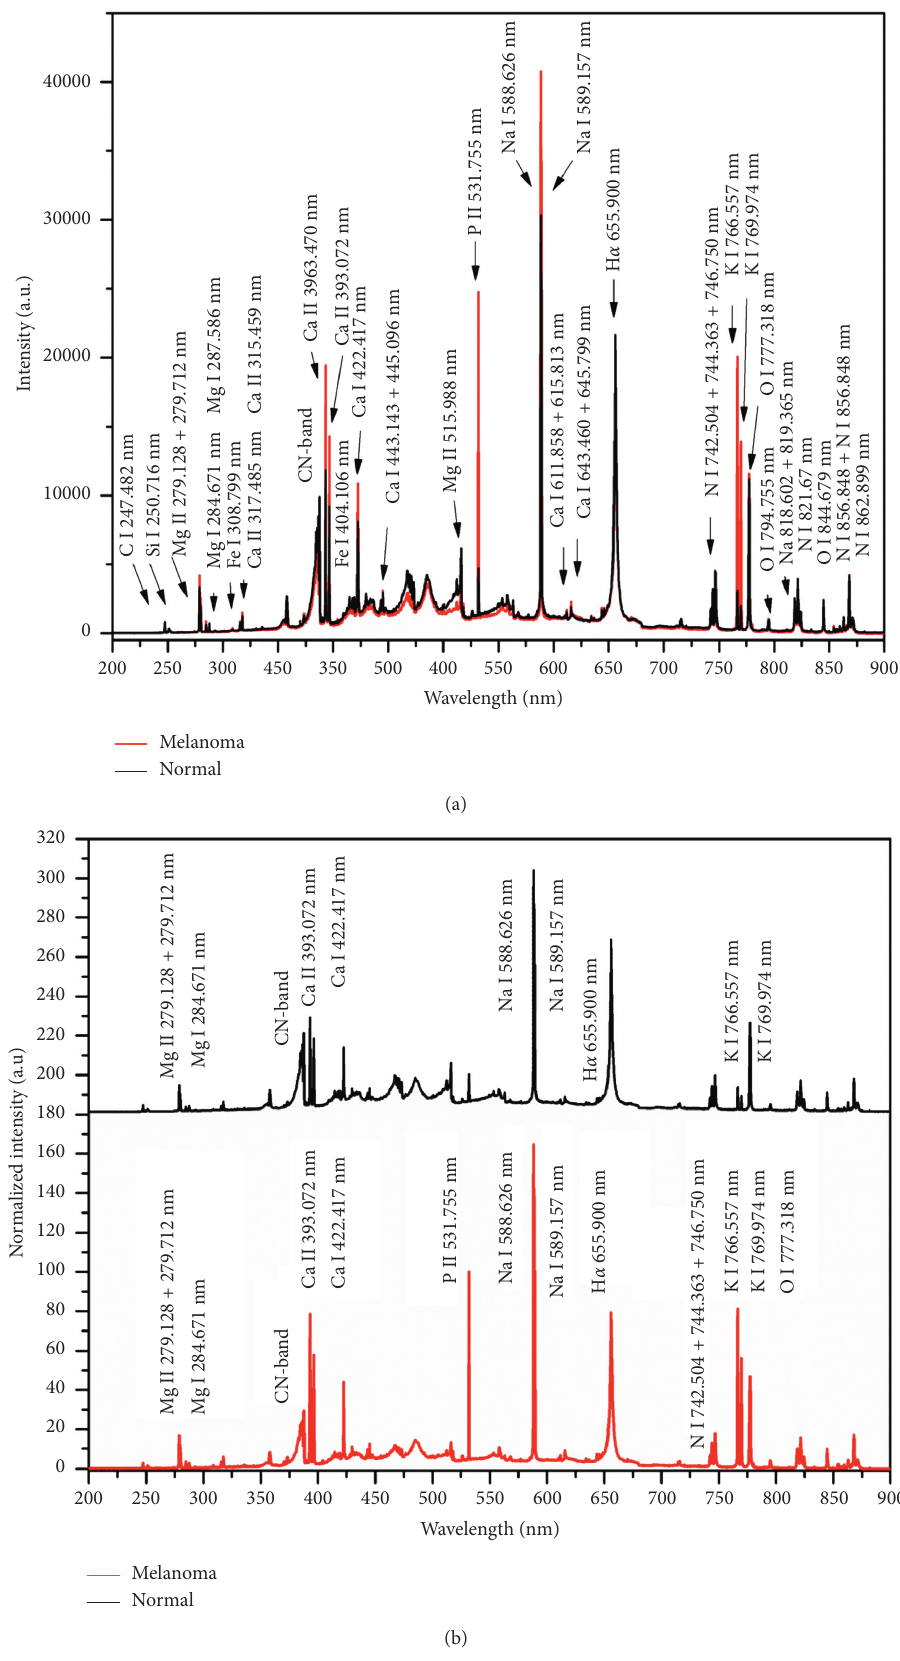
Figure 3: LIBS spectra of human melanoma and normal FFPE tissue samples (average of 111 measurement points of each sample) in the spectral range of 200–900nm. (a) The original and (b) normalized spectra of the FFPE sample of melanoma and normal tissue,